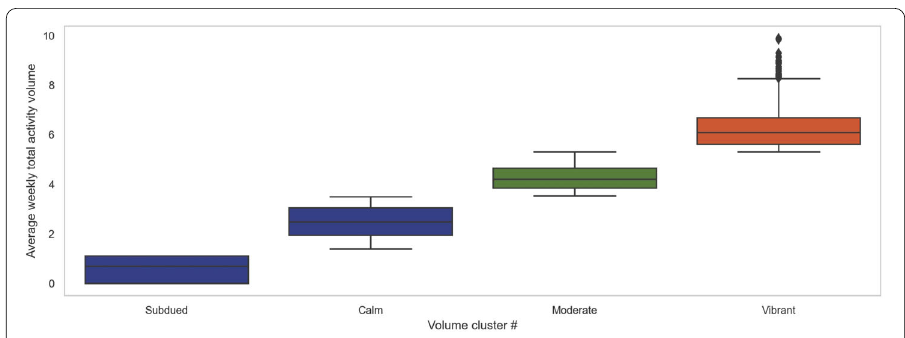
Figure 2 Identification of volume clusters. Boxplots indicating the distribution of average weekly total activity volume in the identified four Volume Clusters, where Subdued , Calm , Moderate and Vibrant Clusters are drawn from left to